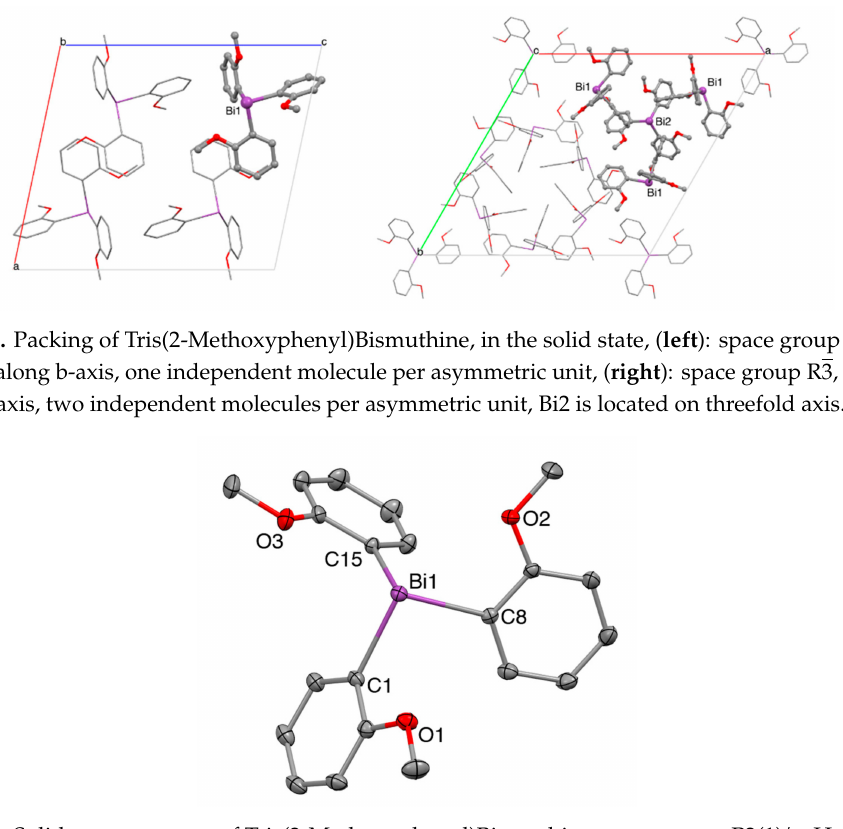
Figure 5. Solid state structure of Tris(2-Methoxyphenyl)Bismuthine, space group P2(1) / c. Hydrogen atoms omitted for clarity, ellipsoids at 50% probability level, distances in Å, angles in deg. Bi1-C1 2.247(3), Bi1-C8 2.250(2), Bi1-C15 2.251(4), Bi1-O1 3.106(5), Bi1-O2 3.059(5), Bi1-O3 3.140(5), C1-Bi1-C8 95.8(1), C8-Bi1-C15 93.4(1), C1-Bi1-C15